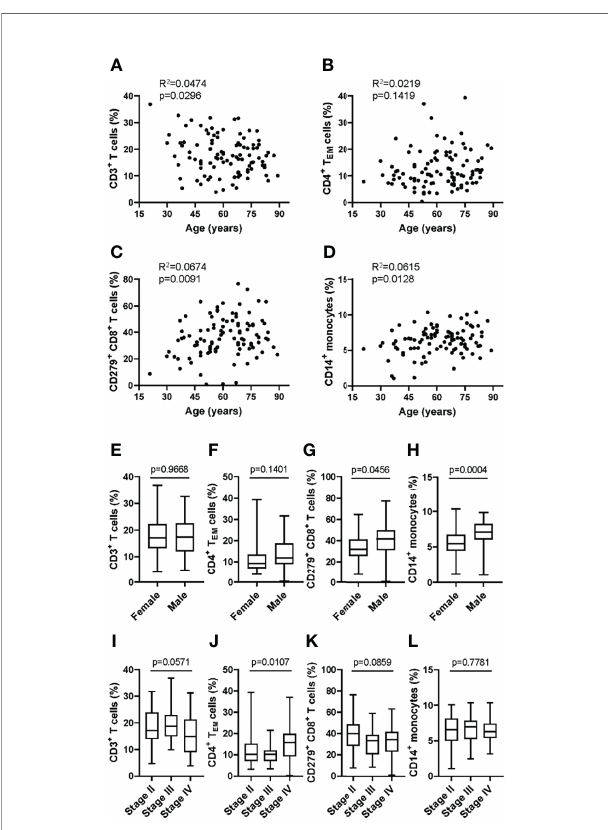
FIGURE 7 | Application of the MoT test to a melanoma patient cohort revealed sex- and stage-dependent differences in T cell and monocyte populations. Fresh whole blood EDTA samples from patients with stage II (n = 52), stage III (n = 21) or stage IV (n = 27) melanoma were investigated using the MoT test. No correlation (Pearson) with age was found for CD3 + T cell % (A), CD4 + T EM cell % (B) , CD279 + CD8 + T cell % (C) and CD14 + monocytes % (D) . No sex-dependent differences (unpaired t test) were found for CD3 + T cells (E) and CD4 + T EM cells (F) . CD279 + CD8 + T cells (G) and CD14 + monocytes (H) were increased in male patients (unpaired t test). (I) CD3 + T cells were decreased in stage IV patients (K.W. test). (J) CD4 + T EM cells showed a signi fi cant stage-dependent increase (K.W. test). No stage- dependent differences (K.W. test) were found in CD279 + CD8 + T cells (K) and CD14 + monocytes (L)